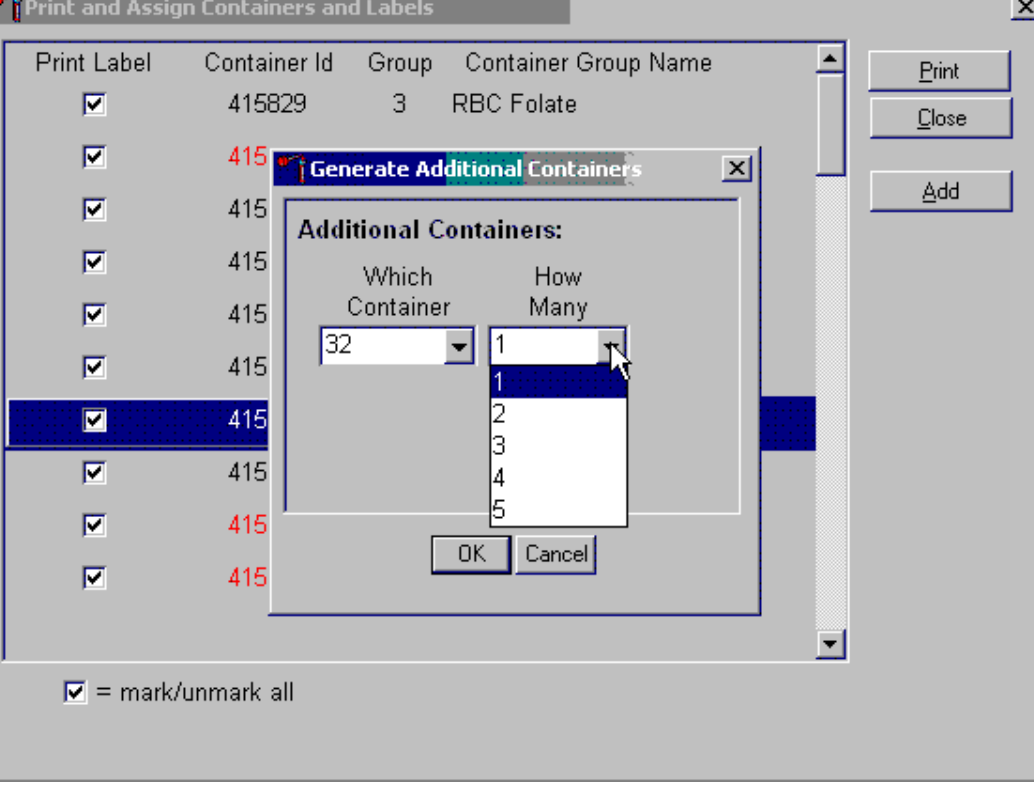
the mouse arrow to the drop-down arrow and left click, then drag the arrow to the desired choice and left click. Use the scroll bar to view all the